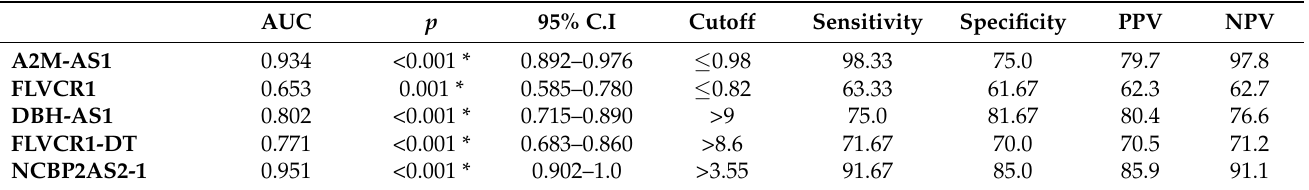
Table 6. Validity (AUC, sensitivity, specificity) for different parameters to discriminate severe group ( n = 60) from moderate group ( n =